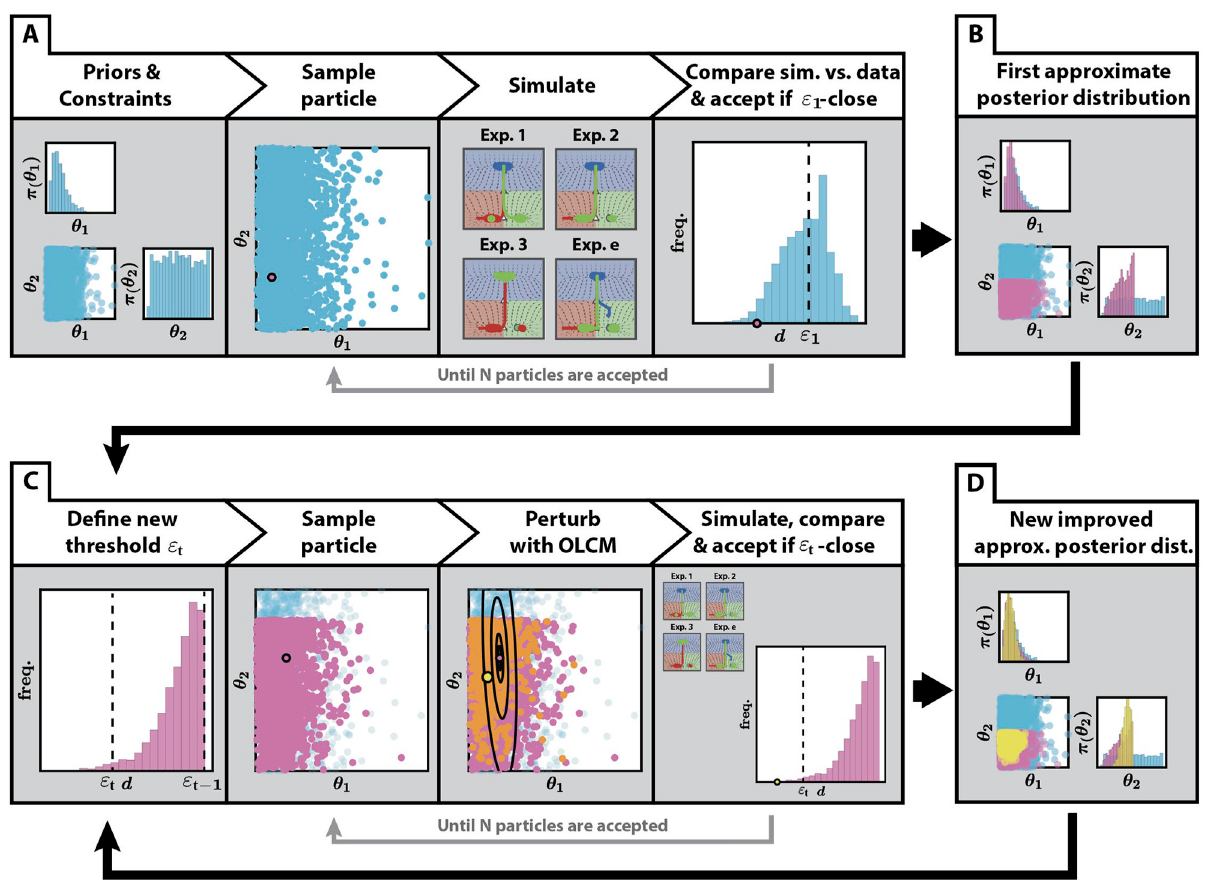
Fig 3. Application of ABC SMC to the fitting of the binary flip with cusp model. (A) First step of the algorithm. Having defined priors for the fitted parameters and constraints between them, as well as an initial threshold ε 1 , particles are sampled from the priors and accepted if the distance between the simulated data and the experimental data is less than the initial threshold. This is repeated until N particles are accepted. (B) An initial approximation of the posterior distribution is obtained, generated by the N particles accepted in (A). (C) The algorithm then proceeds in a sequential manner. In each step t of the algorithm, a new threshold ε t is defined, in our case, the 0.3 quantile of the previous distribution of distances ε t − 1 . Particles are sampled from the last approximate posterior distribution and perturbed using a Markov Kernel obtained from the Optimal Local Covariance Matrix (OLCM) [35] (black ellipses in the figure represent confidence intervals), (as described in S1 Appendix). This is repeated until N new particles that satisfy the distance threshold are accepted. Also, each new particle is assigned a weight proportional to its prior probability and inversely proportional to the Markov Kernels evaluated at this particle, which control for efficient exploration. (D) After each step, a new improved approximate posterior distribution is obtained, which restricts the values of the parameters to a restricted region of the parameter set.